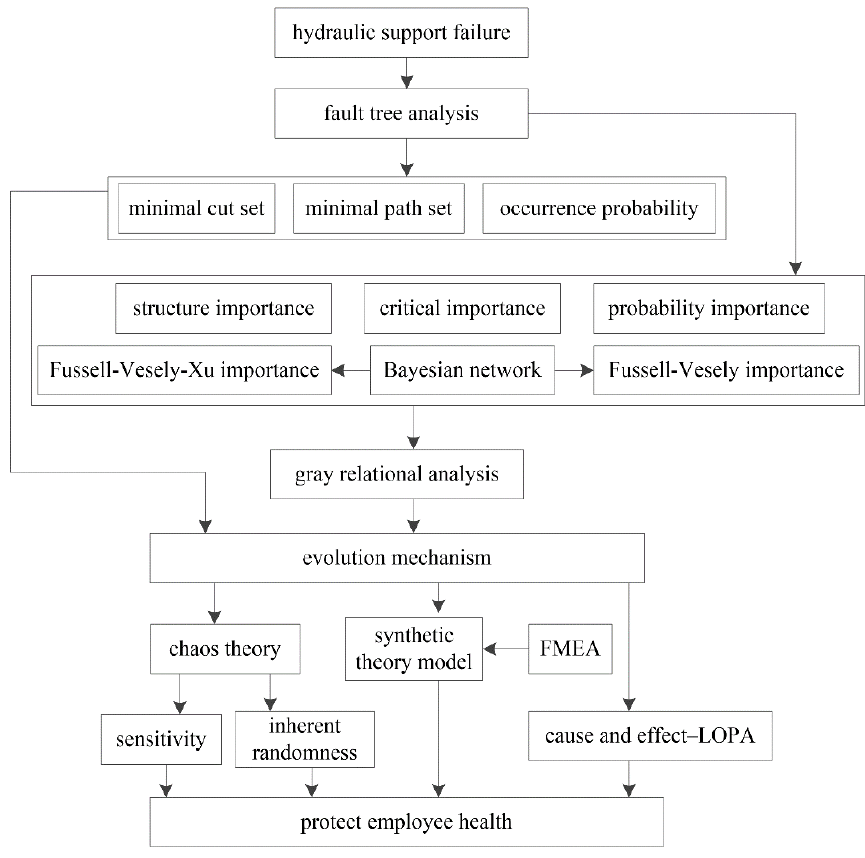
Figure 1. Framework of this study.